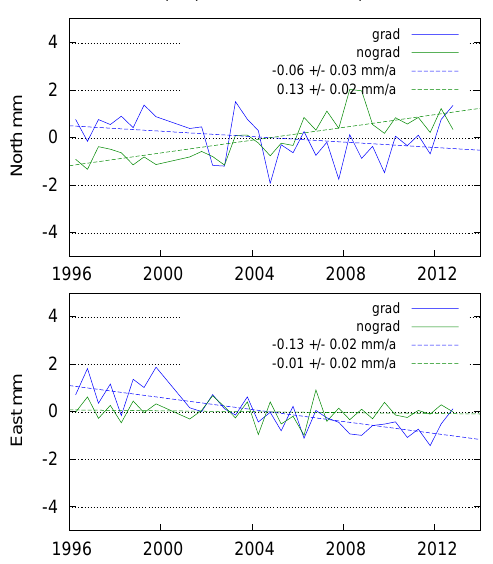
Figure 4. An effect of tropospheric gradient estimation at pillar 2. Blue lines correspond to the coordinate solution with gradi- ent estimated and green lines without gradient estimation.